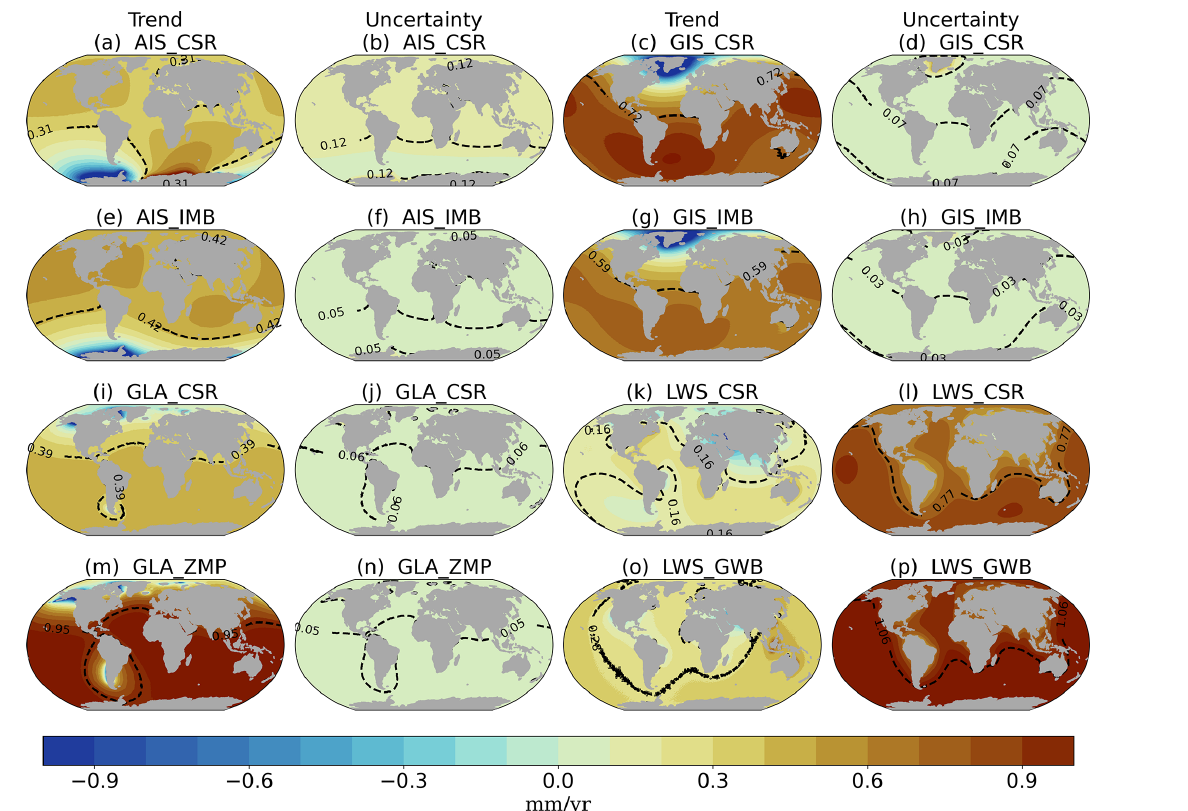
Figure B3. GRD-induced sea-level trend and temporal uncertainty (mmyr − 1 ) for GRACE (CSR) and independent combination (IMB + ZMP + GWB) for 2003–2016. The black dashed contour line and number indicate the spatial average of the regional trend and uncertainty. Complementary to trends and uncertainties of Fig.